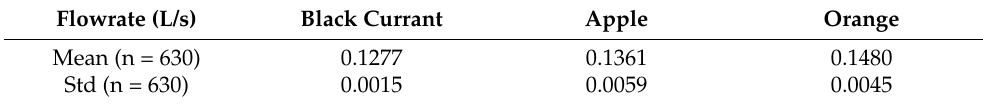
Table 1. Measured flowrate of currant nectar, apple juice, and orange juice at 70 ◦ C. Flowrate (L/s) Black